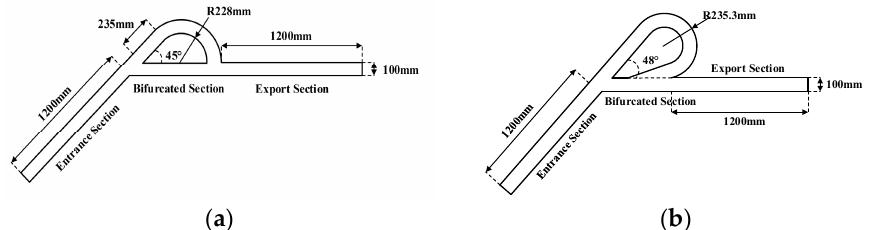
Figure 1. Schematic diagram of size and structure of two Tesla valves (mm) (( a ) T45-R, ( b ) GMF, and the width of entrance is 100 mm).